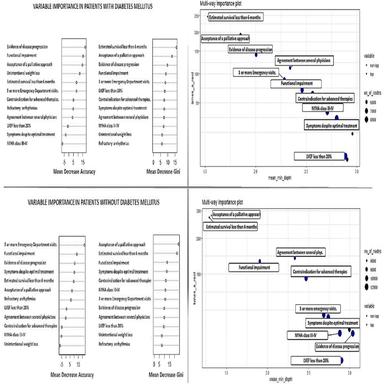
Importance of variables in patients with and without diabetes mellitus according to random forest algorithm. Left: Importance of variables according to mean decrease in accuracy and mean decrease in Gini. Further explanation is available in the article and in reference 12. Right: multi-way importance plot. The size of the points reflects the number of nodes split on the variable. The top ten variables are highlighted in blue. The x-axis shows the mean minimal depth calculated using top trees (minimal depth